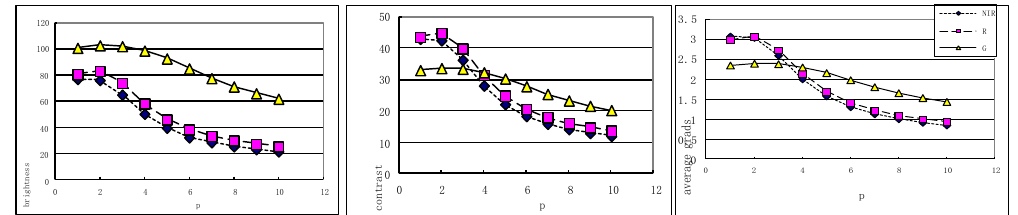
Figure 5. Change trends of brightness, contrast and average gradients when p value from 1~10 in color infrared aerial image shadow